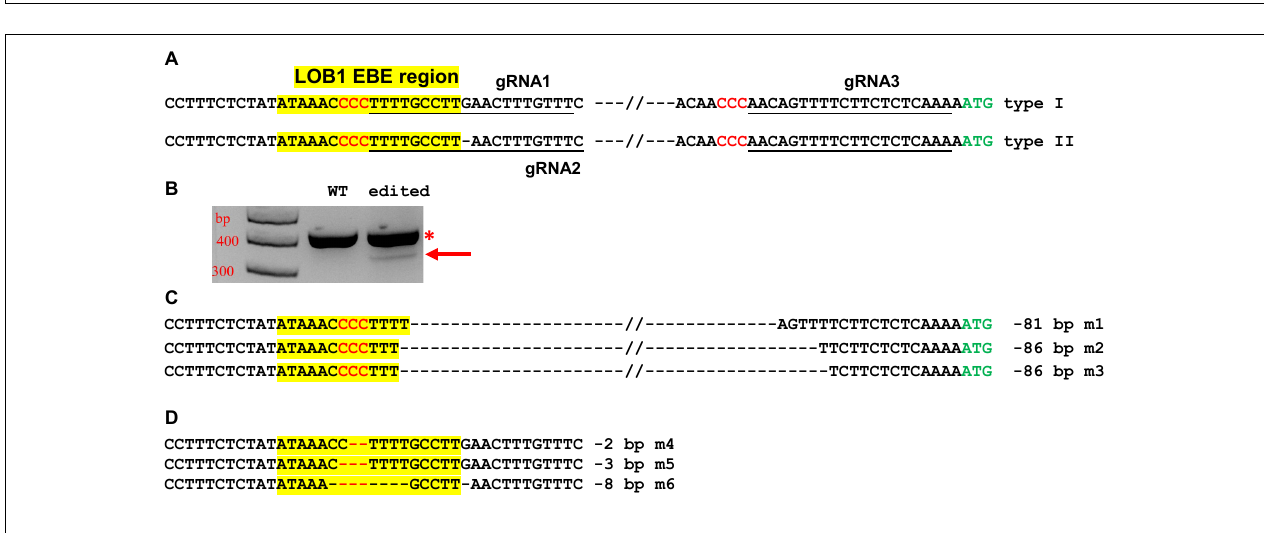
FIGURE 3 | CsLOB1 editing in Hamlin sweet orange protoplasts. (A) CsLOB1 promoter contains two different types. The EBE region was highlighted with yellow; regions chosen for gRNAs were underlined; PAM was shown in red. The final CRISPR constructs contains three gRNAs as indicated. (B) PCR products generated by two primers spanning the EBE and last gRNA. The PCR product with an arrow was amplified from the deletion mutants. (C) Sanger sequencing results of the PCR product with the arrow in (B) . Twenty clones were sequenced. m1, 11 clones; m2, 5 clones; m3, 4 clones. (D) Sanger sequencing results of the PCR products marked by ∗ in (B) that were cloned for colony sequencing. Ninety-four clones were sequenced. m4, 2 clones; m5, 2 clones; m6, 1 clone; WT, 89 clones.